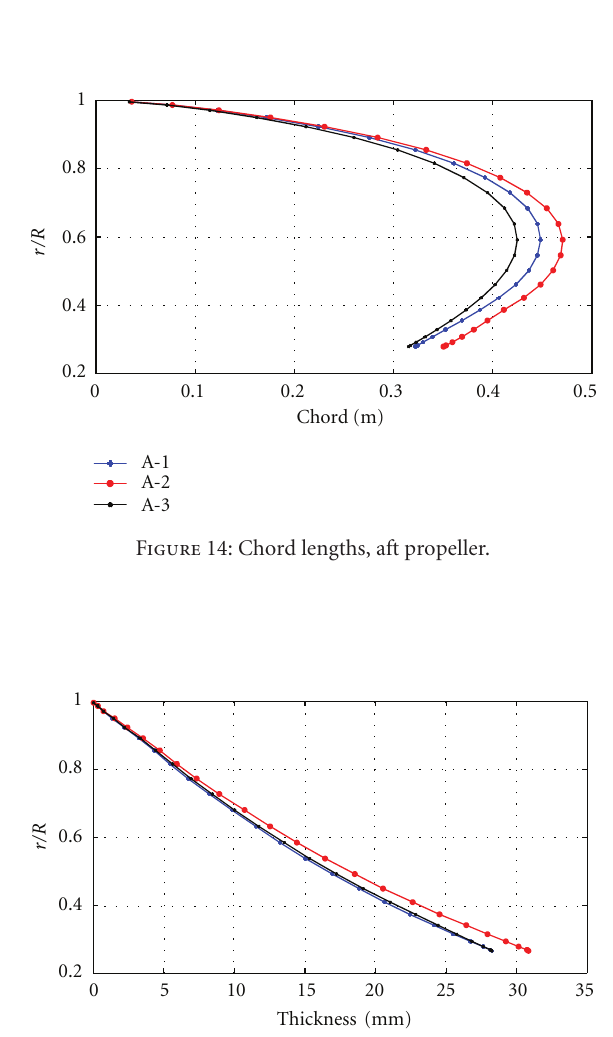
Figure 12: Comparison between numerical and experimental total torque coe ffi cients of a CRP set designed with the proposed method. Table 2: Design conditions for the propellers used in the parametric investigation.